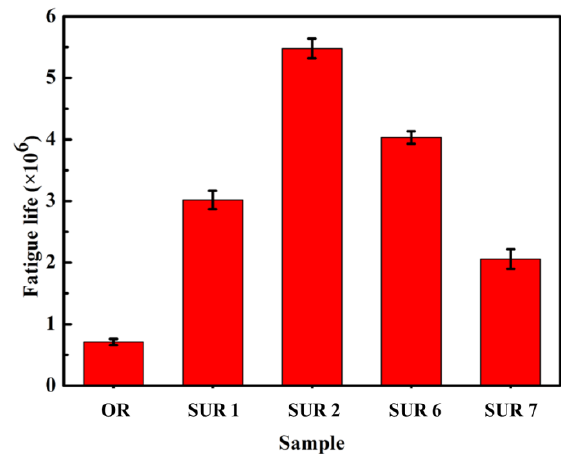
Figure 11. Fatigue life changes.